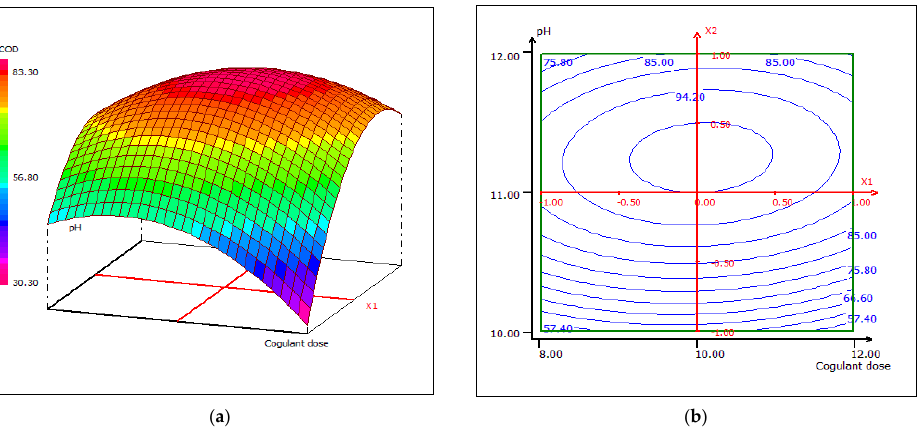
Figure 23. Three-dimensional ( a ) andtwo-dimensional ( b ) response surface plots for the COD of the treated food wastewater using β-chitin extract as a function of coagulant dose and pH, when temperature was maintained at 23 °C.